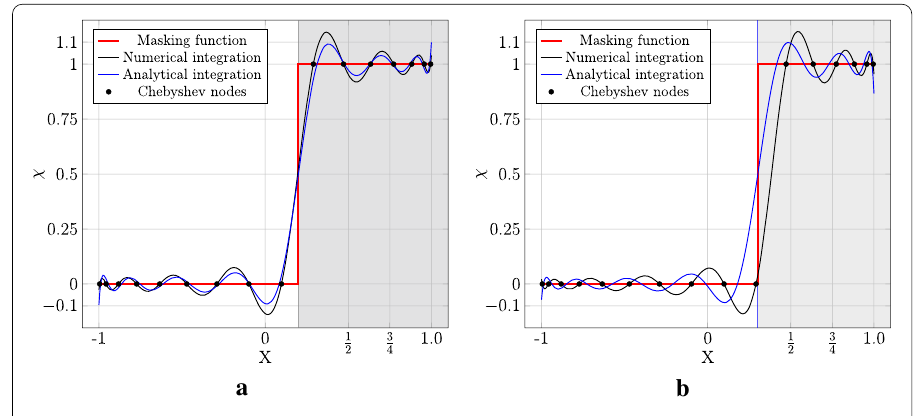
Fig. 1 Immersed boundary (red) representation in polynomial space with 16 terms. Comparison of the numerical (black) and the analytical integration (blue) for the masking function χ . Black dots represent the non-equidistant integration points (Chebyshev nodes). a Wall location between two Chebyshev nodes and b wall location exactly at a Chebyshev node